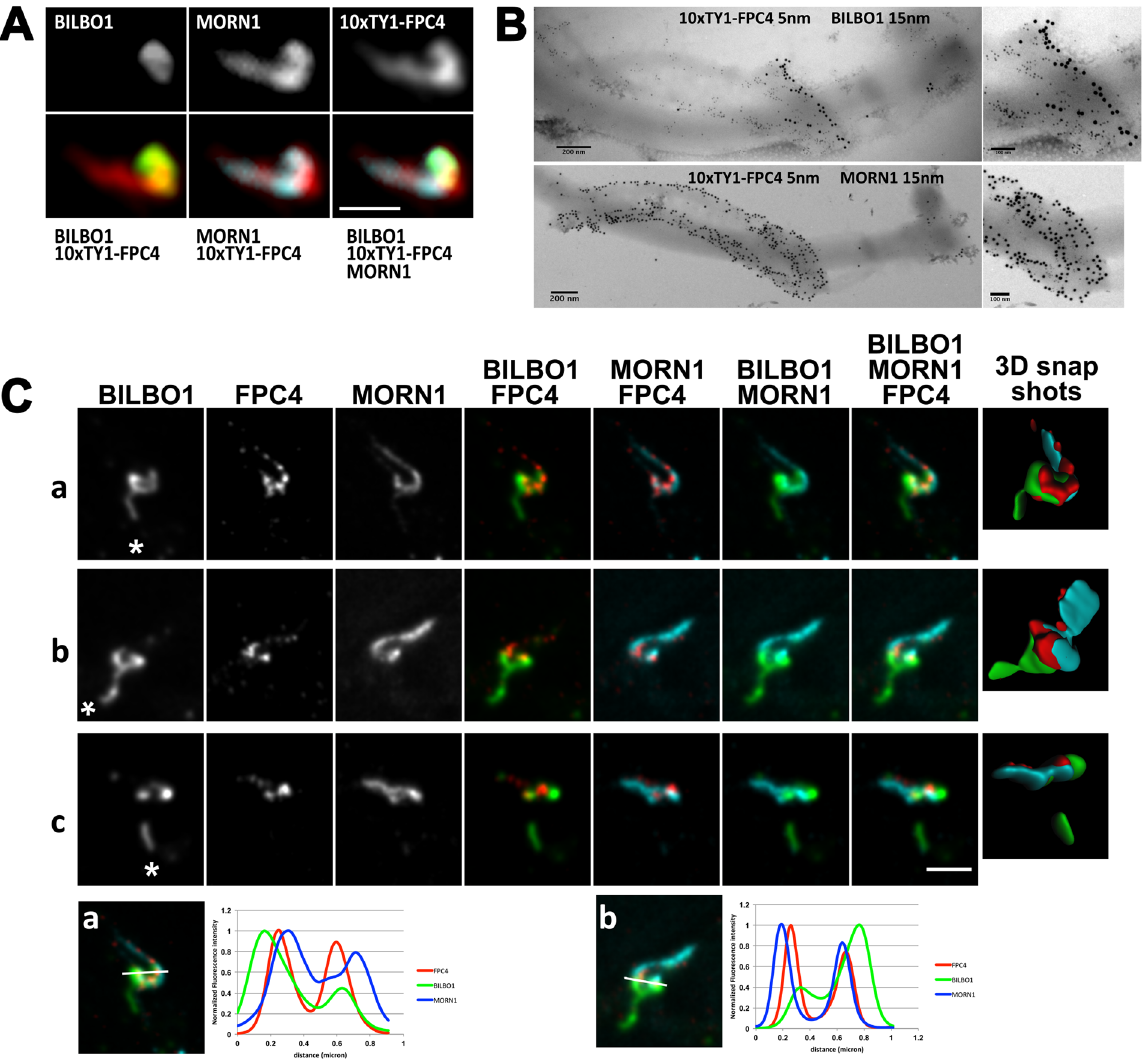
Fig 4. Immuno-localisation of endogenously tagged 10xTY1-FPC4, BILBO1 and MORN1. (A) Wide-field microscopy observation of the triple labellingof BILBO1, MORN1 and FPC4 on cytoskeleton from a SmOxP427 cell line expressing endogenously 10xTY1 tagged FPC4. (B) Immuno-electron microscopy on flagellalabelledwith anti-TY1 for FPC4 (5 nm gold beads), anti-BILBO1 (15 nm gold beads), and anti-MORN1 (15 nm gold beads). (C) STED confocalmicroscopy views of the co-labellingof BILBO1, MORN1 and FPC4 on cytoskeletons from a SmOxP427 cell line expressingendogenously 10xTY1 tagged FPC4 (a-c). The asterisks indicate the kinetoplast positionrelative to the structure. The snapshotsof the 3D reconstructions show the close proximity of BILBO1 (green), FPC4 (red) and MORN1 (cyan). (D) Normalisedintensities Plot corresponding to the section indicatedby the white lines (a, b) indicatethe co-localisation of the proteins. In A and B, scale bars represent 1 μ